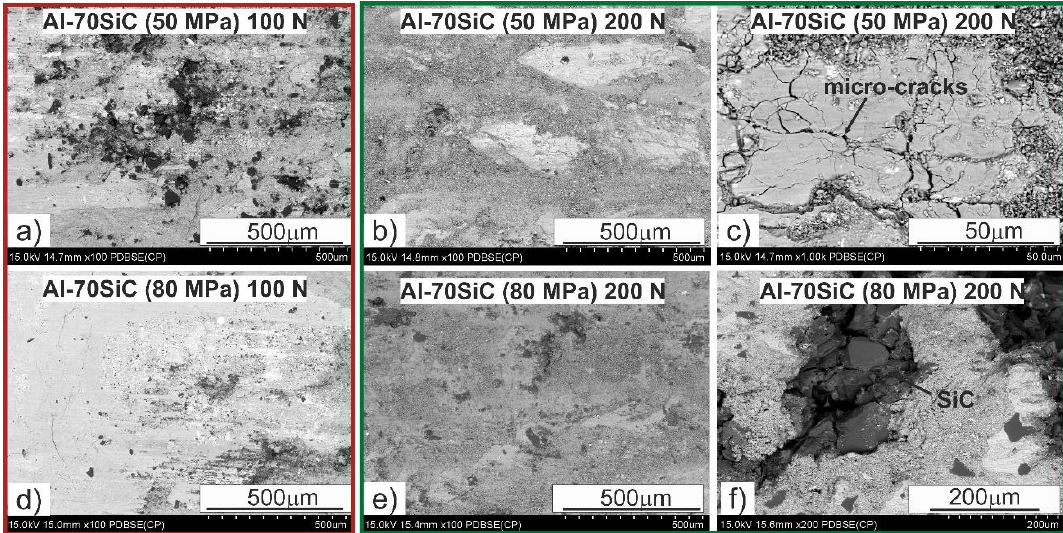
Figure 10. Al-70SiC specimen surfaces after tribological tests.